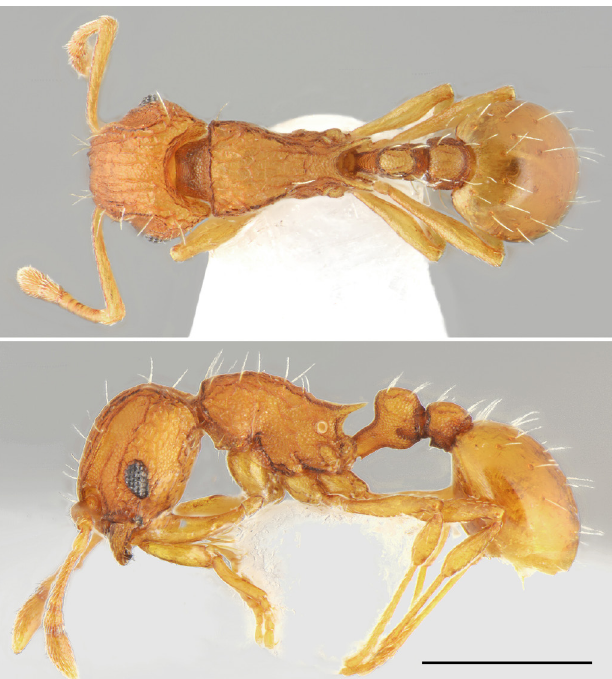
Fig 1 . Habitus of worker of Wasmannia auropunctata (Roger, 1863), dorsal and lateral, collected from Cyprus (locality Kissonerga): scale bar 0.5 mm (photographed by L.